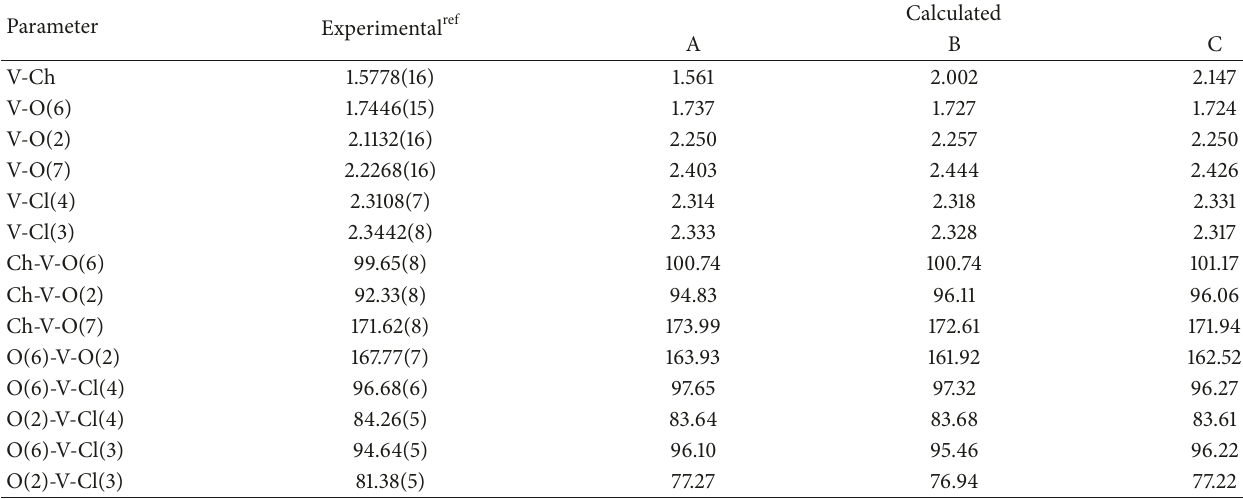
Table 1: Selected bond lengths (˚A) and angles ( ∘ ) for the respective complexes.